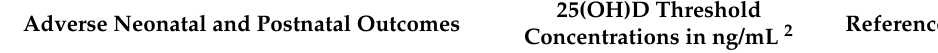
Table 2. Concentrations of 25(OH)D threshold concentrations associated with adverse neonatal and postnatal outcomes.